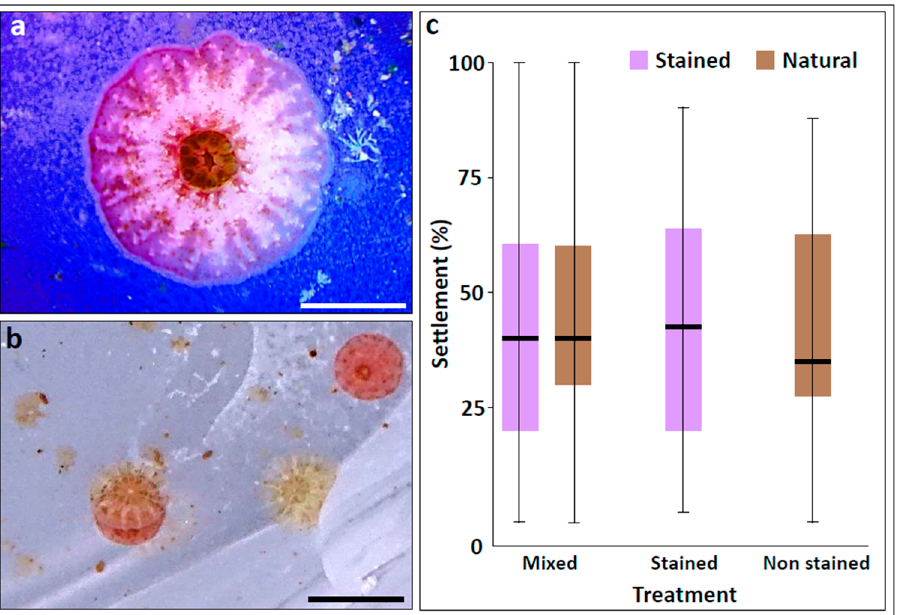
Figure 3. ( a , b ) Two days post-settlement. ( a ) A primary polyp developed from a stained planula. Scale bar is 500 μ m. ( b ) A clustered settlement of two stained and two un-stained planulae that settled and metamorphosed. One stained and one unstained aggregate. Scale bar is 1000 μ m. ( c ) Box plot for settlement percentages. Lower and upper hinges correspond to the 25th and 75th percentiles. The upper/lower whisker extends from the hinge to the largest/smallest value of 1.5 × IQR (interquartile range) from the hinge. The horizontal line corresponds to the median value. Brown boxes refer to unstained planulae and purple boxes to the stained planulae in each